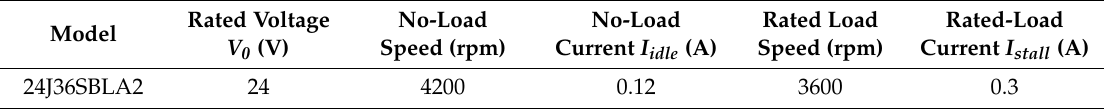
Table 3. Specifications of the brushless direct current (BLDC)